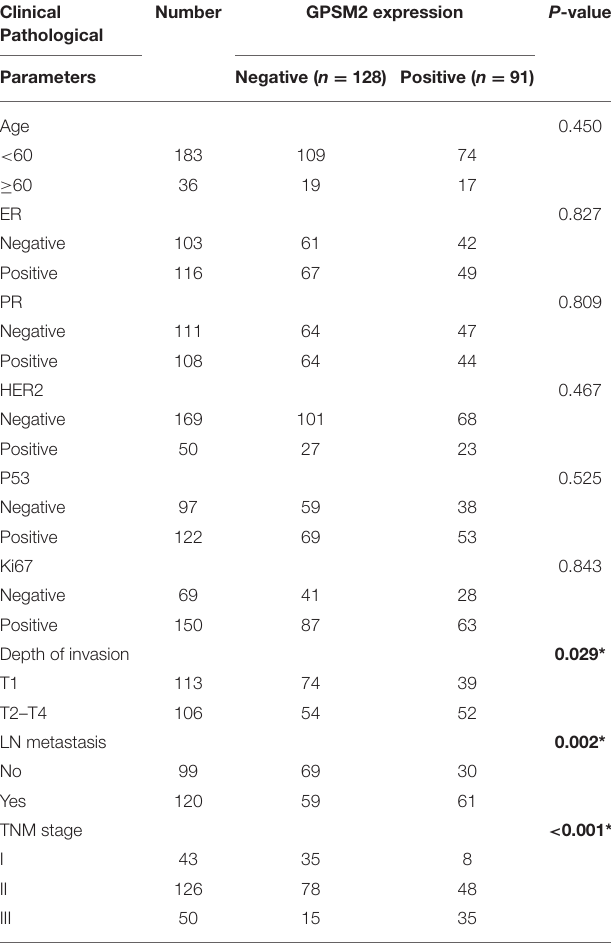
TABLE 1 | Correlation between GPSM2 expression and clinical characteristics in breast cancer patients ( n = 219). Clinical